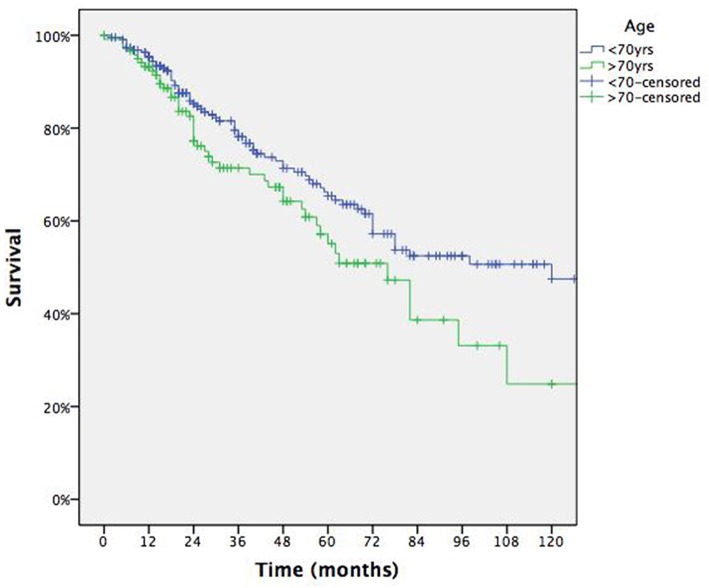
Survival according to age.